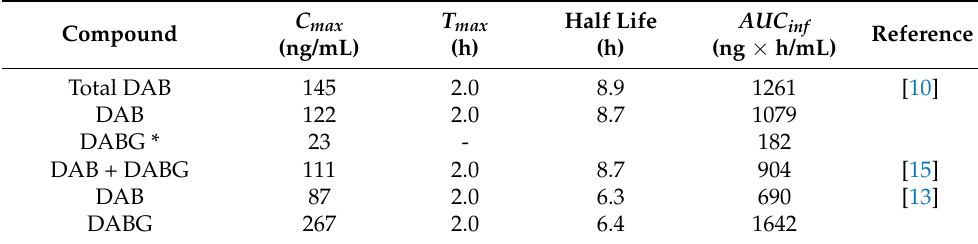
Table 1. Summary of the pharmacokinetic profiles of DAB and DABG after oral administration of 150 mg